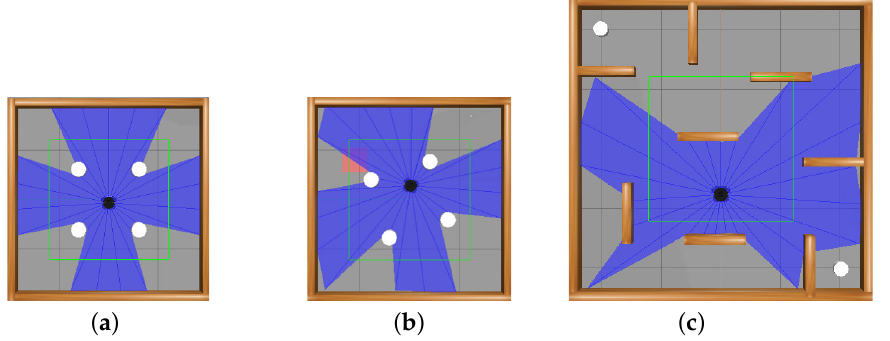
Figure 7. Simulation environment. ( a ) stage 2; ( b ) stage 3; ( c ) stage